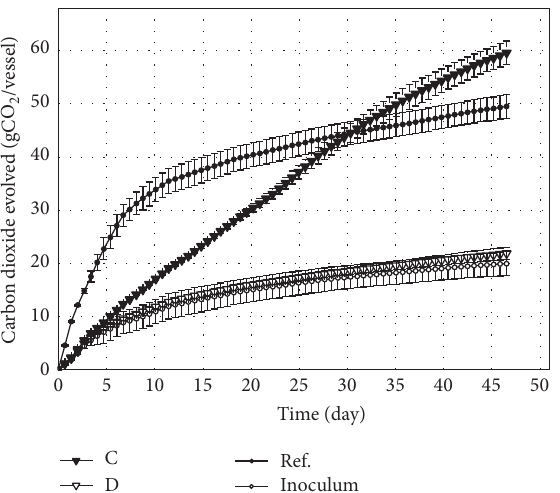
Figure 7: Second biodegradation trial: percentage of mineralization of polymers tested. (C) PLA/PBAT blend; (D) polyethylene film, negative reference; (Ref) reference, cellulose. Error bars refer to standard error ( 𝑛 = 3